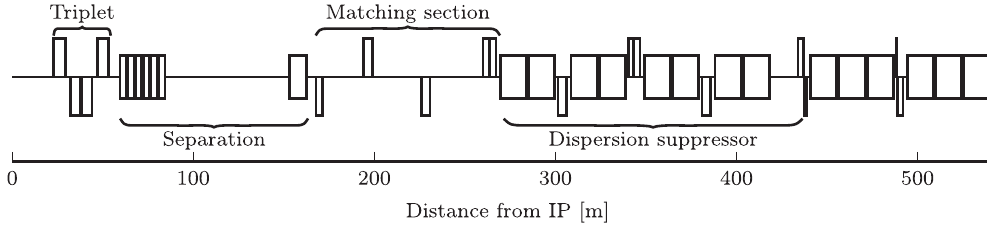
FIG. 1. Layout of the LHC interaction